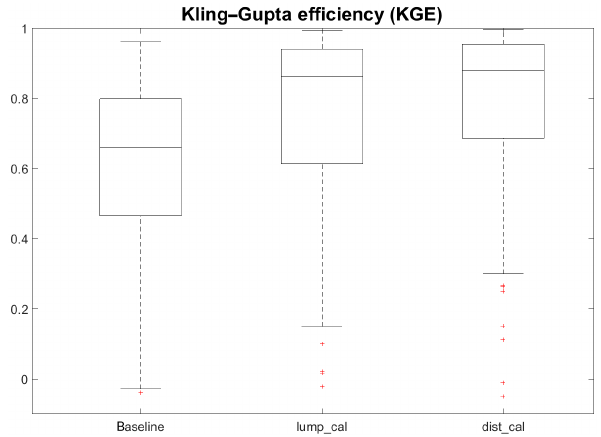
Figure 2. Kling–Gupta efficiency of the simulated basin-level total runoff across the global 235 basins (lump: lumped; dist: distributed; cal: calibration; the x axis labels of “lump_cal” or “dist_cal” repre- sent the lumped/distributed scheme during the calibration